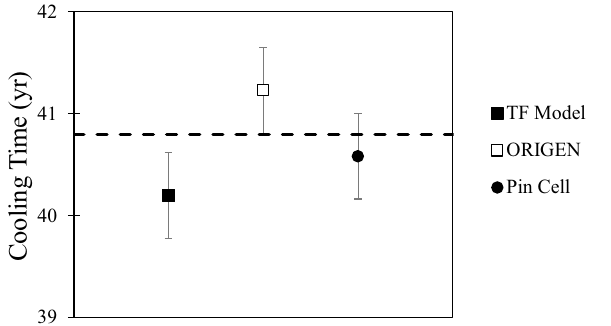
Figure 10. Cooling times calculated from various reactor models. The known cooling time of 40.8 years is indicated by the dashed line. Uncertainties are